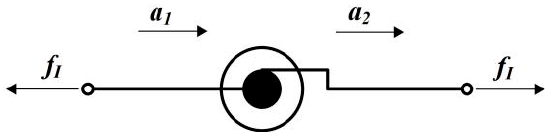
Figure 1. Mechanical model of an inerter element.